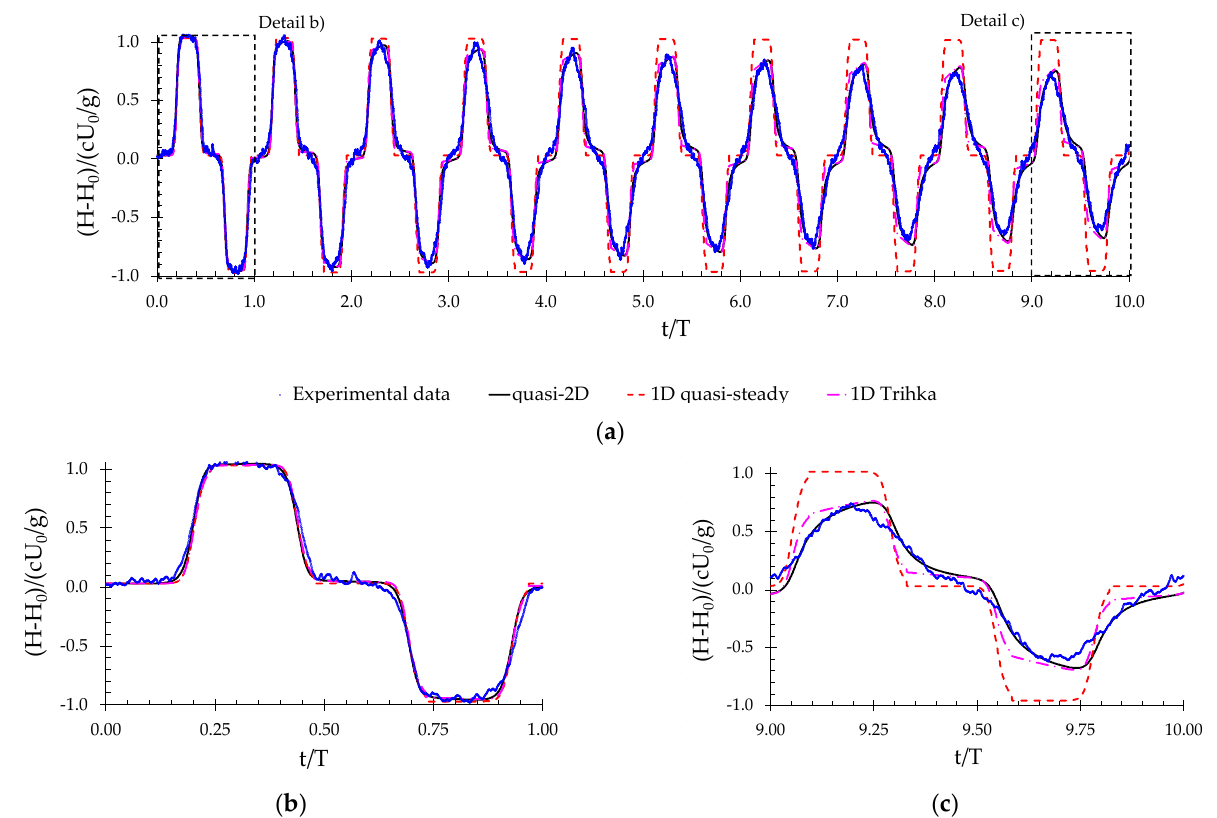
Figure 16. Piezometric head time history at conduit midsection, comparing experimental data, quasi-2D and 1D models: ( a ) 0.0 ≤ t/T ≤ 10.0; ( b ) 0.0 ≤ t/T ≤ 1.0; ( c ) 9.0 ≤ t/T ≤ 10.0.